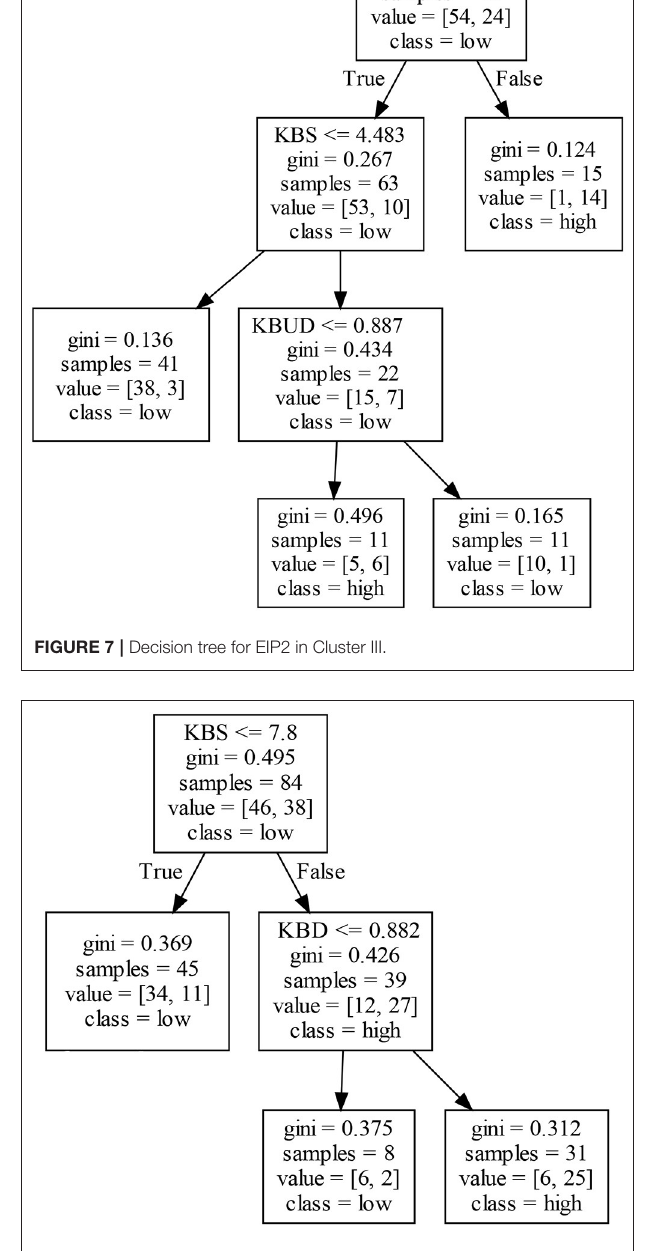
FIGURE 8 | Decision tree for EIP1 in Cluster